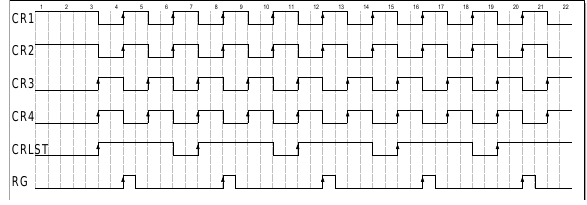
Figure 9. Horizontal binning clock sequence Diagram For vertical binning, several parallel line transfers occur in a row while the HCCD is in steady-state conditions (receiving charge packets from the image section). Charge packets from individual pixels are summed up in HCCD elements directly. Again, for a binning factor of N, N vertical transfer clocks (N CIX period) must be applied during a single line transfer time （ one SCK or TCK period).